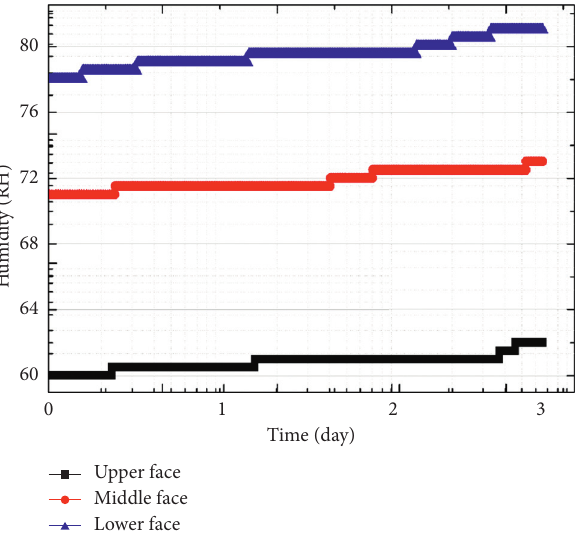
Figure 14: Humidity changes.